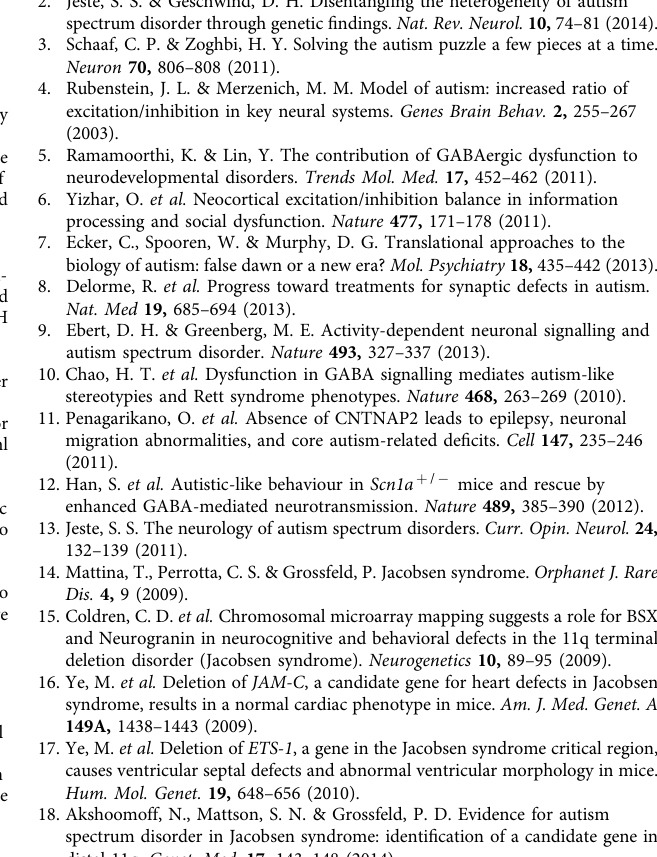
Fig. 3g, mouse mAb to g 2 (1:500; Synaptic Systems) and rabbit pAb to early endosome antigen 1 (1:100; Cell Signaling Technology) were used. Cell nuclei were visualized with TO-PRO-3 iodide (1:10,000; Invitrogen). Quantitative analyses of the colocalization were performed using ImageJ, based on the previously reported method 42 .